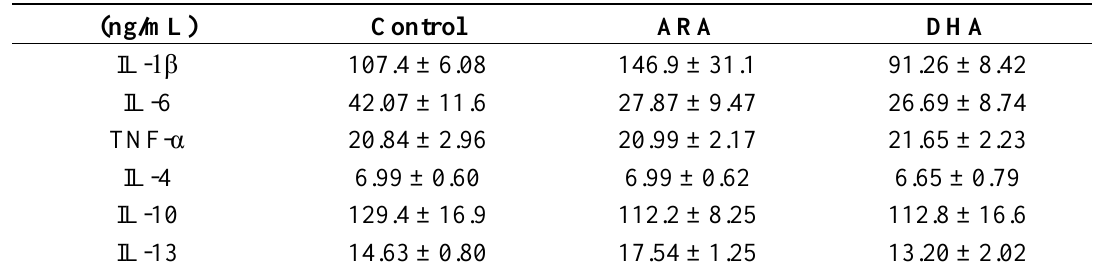
Table 3. Inflammatory cytokine levels in